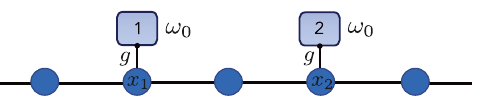
Figure 3: Schematics of two atoms, 1 and 2, coupled to a photonic bath (in this case sketched as a simple lattice). Each emitter has and is coupled to the cavity x frequency 𝜔 0